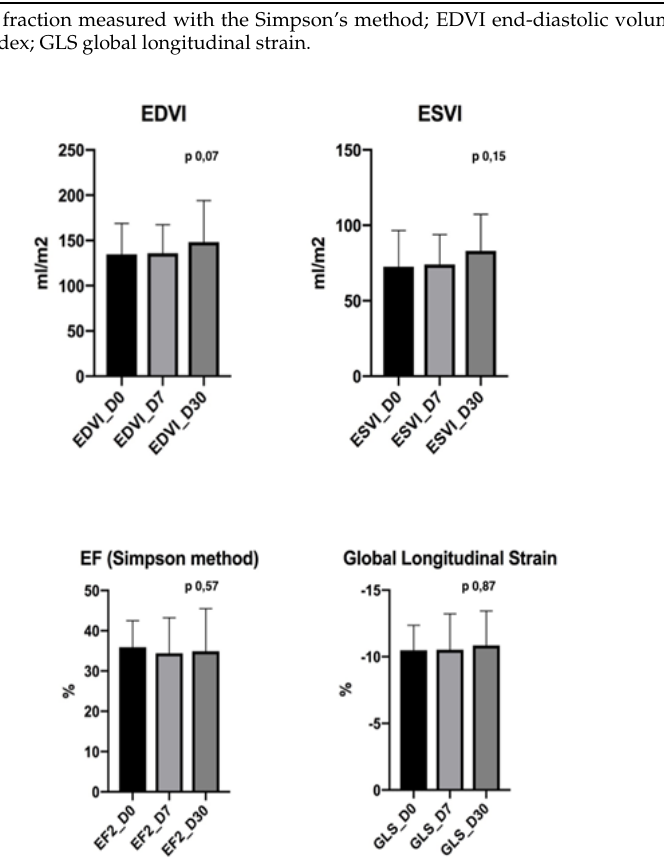
Figure 4. Both conventional and strain echocardiographic parameters remained stable throughout the study, without significative differences pre- and post-procedure, indicating the absence of direct adverse repercussions on heart function.